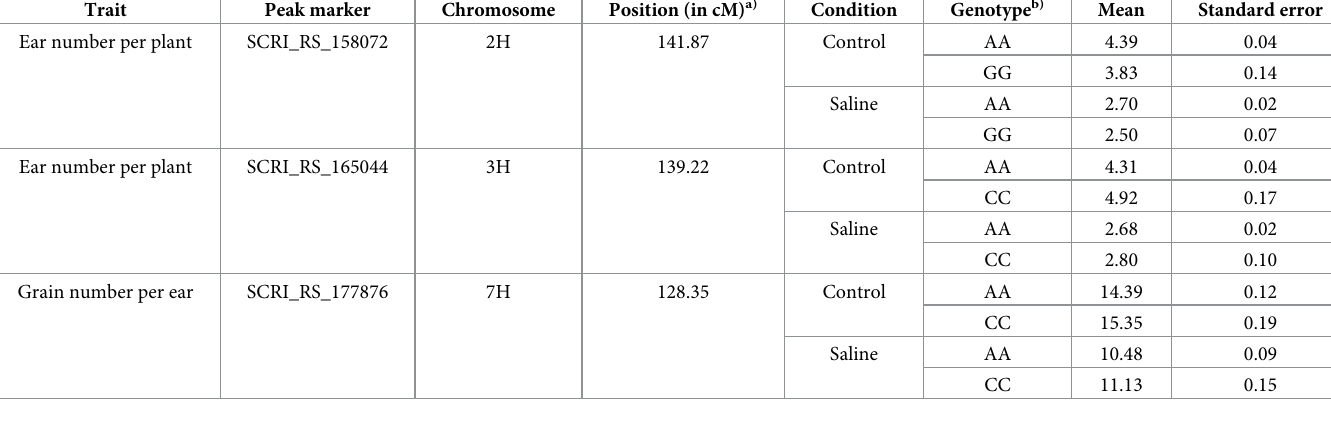
Table 2. Comparison of trait (ear number per plant and grain number per ear) means between accessions by condition (control or saline) and genotype (at peak markers).